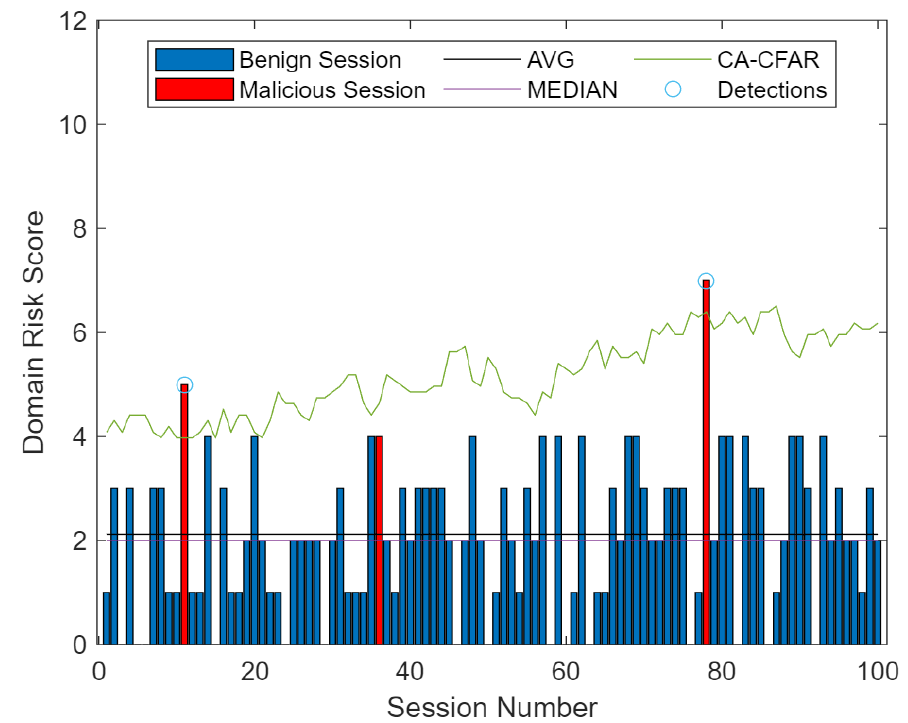
Figure 20. Detection based on the information about domain